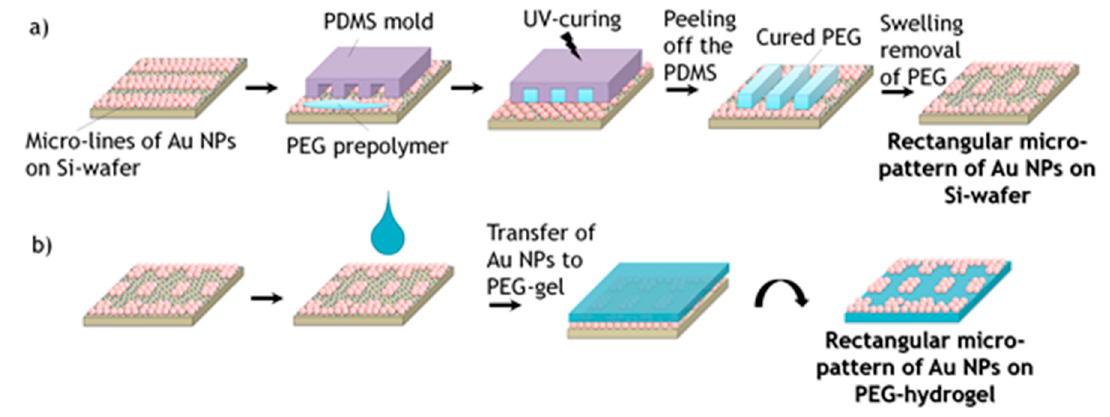
Figure 3 . Schematic representation of the fabrication of rectangular patterns of Au NPs on PEG-hydrogels using wet µ–CdP process: ( a ) rectangular micro-patterning of Au NPs on silicon wafer via MIMIC process; ( b ) transfer of rectangular micro-pattern of Au NPs onto PEG-hydrogel.